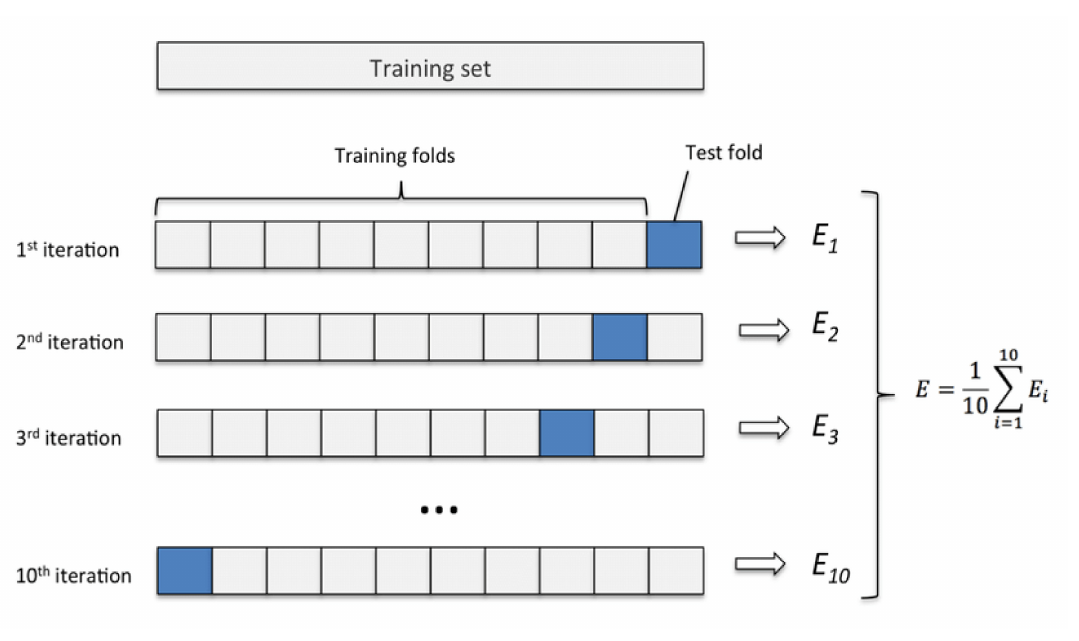
Figure 7. K-fold cross-validation method with subdivision of the training set into k = 10